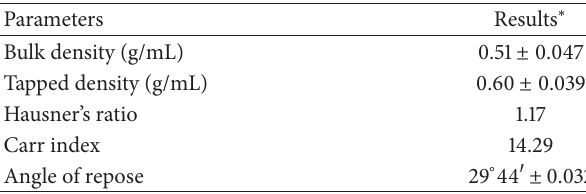
Table 2: Results of micromeritic properties of S. tora seed